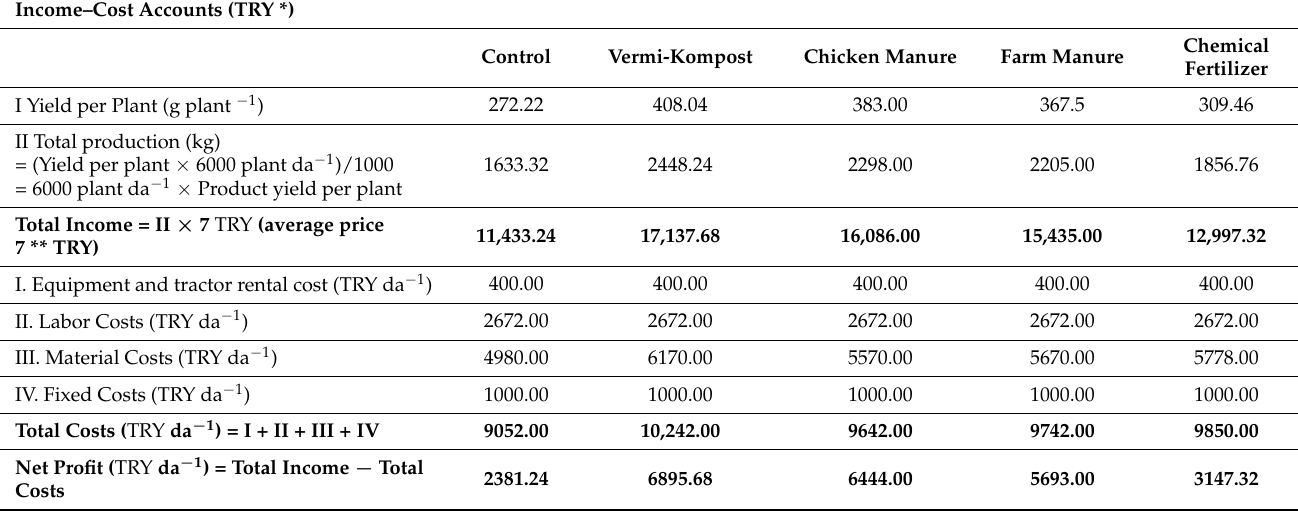
Table 9. Economic analysis results of fertilizer applications in strawberry